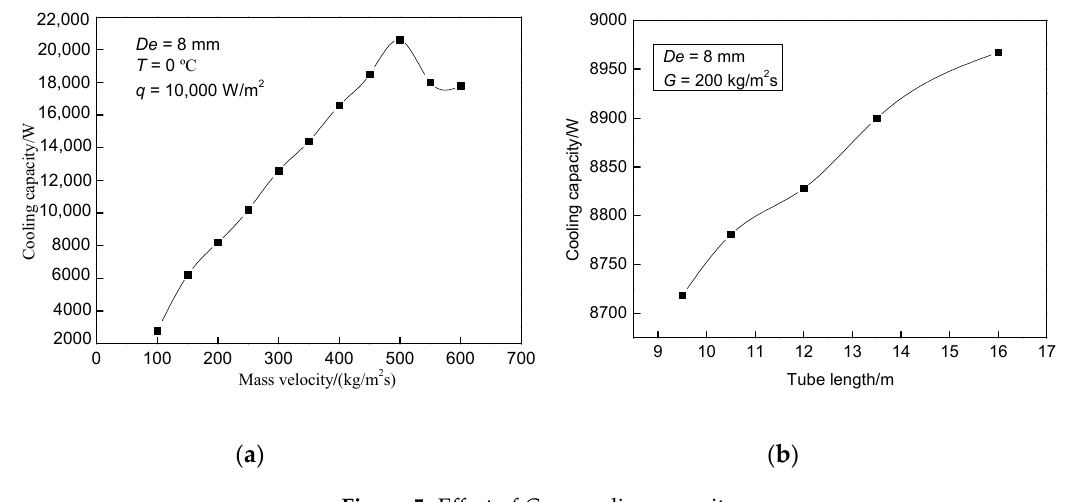
Figure 4. Effect of G on h r.